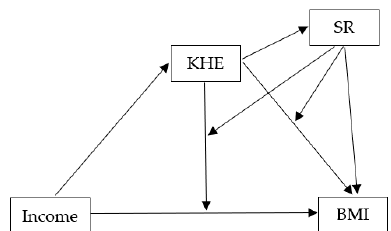
Figure 1. Conceptual Model of mediational and moderator role of the complexity of knowledge about healthy eating (KHE) on the relation of family’s income and BMI Z-scores, and the mediator/moderator role of self-regulation (SR) in the KHE and BMI Z-scores relationship.